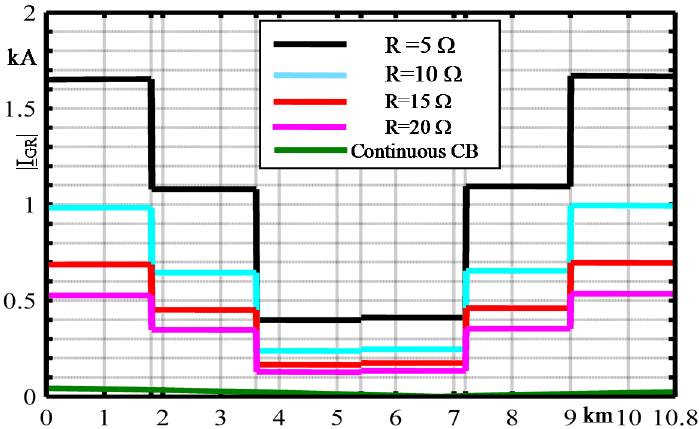
Figure 5. Faulted UGC: ground return current magnitudes along the line (CB with PTs) for different CB box resistances; FAULT at midline.